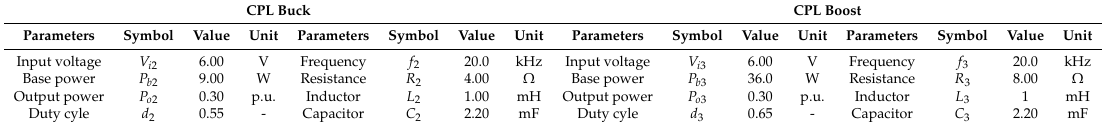
Table 3. Buck and boost converter parameters operating as CPL.